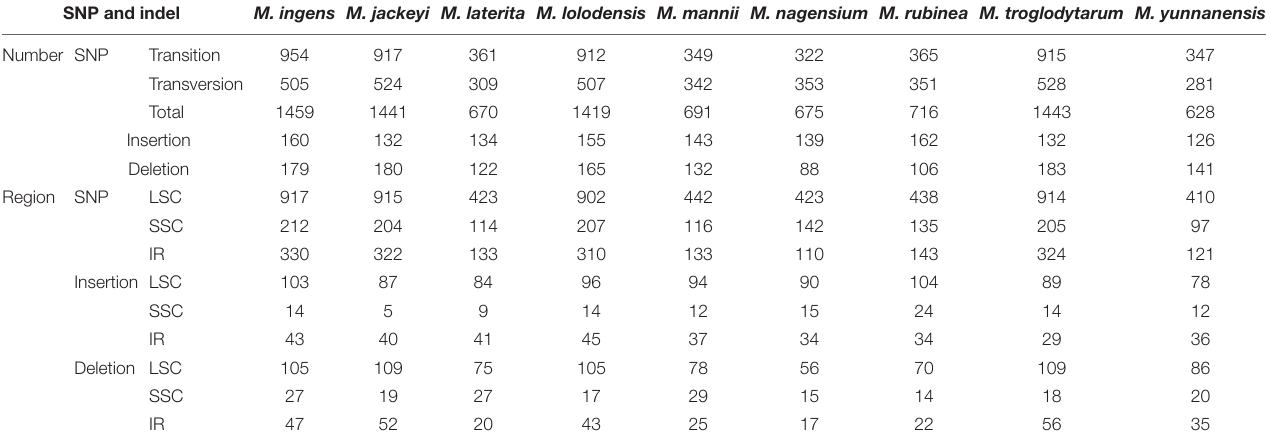
TABLE 3 | Details of single nucleotide polymorphisms (SNP) and InDel sites in large single-copy region (LSC), small single-copy region (SSC), and inverted repeat (IR) regions in the complete chloroplast genomes of nine Musa species. SNP and